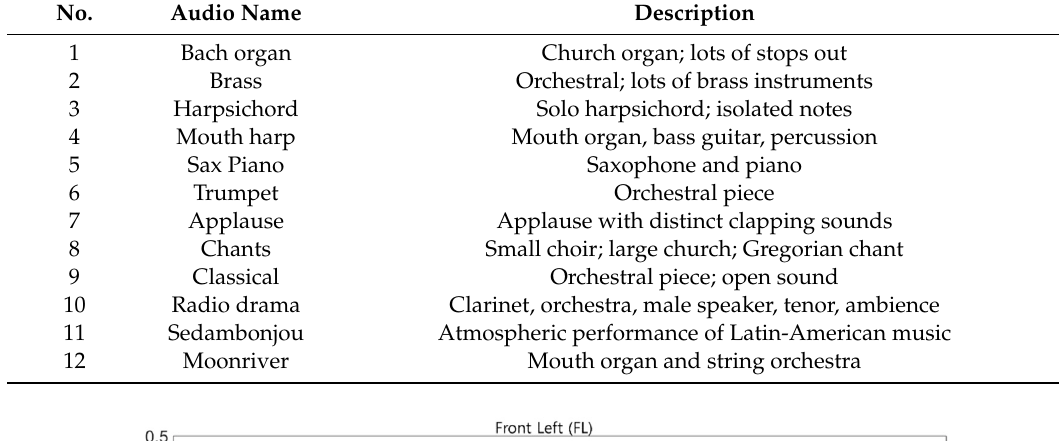
Table 7. 5.1 channel host audio used in the experiment.